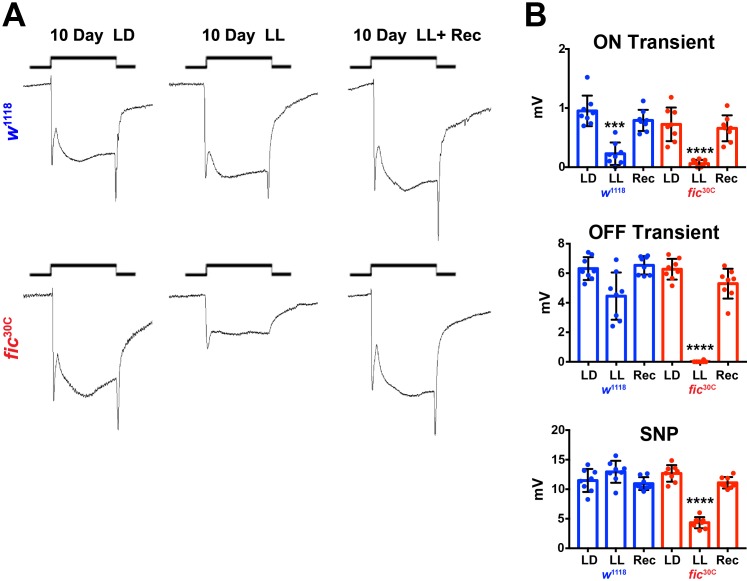
Fic30C mutants recover ERG properties in 72 hours after 10 days of LL.(A) Representative ERGs of flies following 10 days of LL, 10 days LD (500 lux), and 3 days Recovery following 10 days. (B) Quantification of ERG data. Bar graphs show means ± SD. ****p<0.0001; ***p<0.001; *p<0.05; n = 8 flies per genotype and condition.10.7554/eLife.38752.018Figure 3—figure supplement 3—source data 3.Relates to Figure 3—figure supplement 3B.Quantification of ERG components with 10 days of LL.